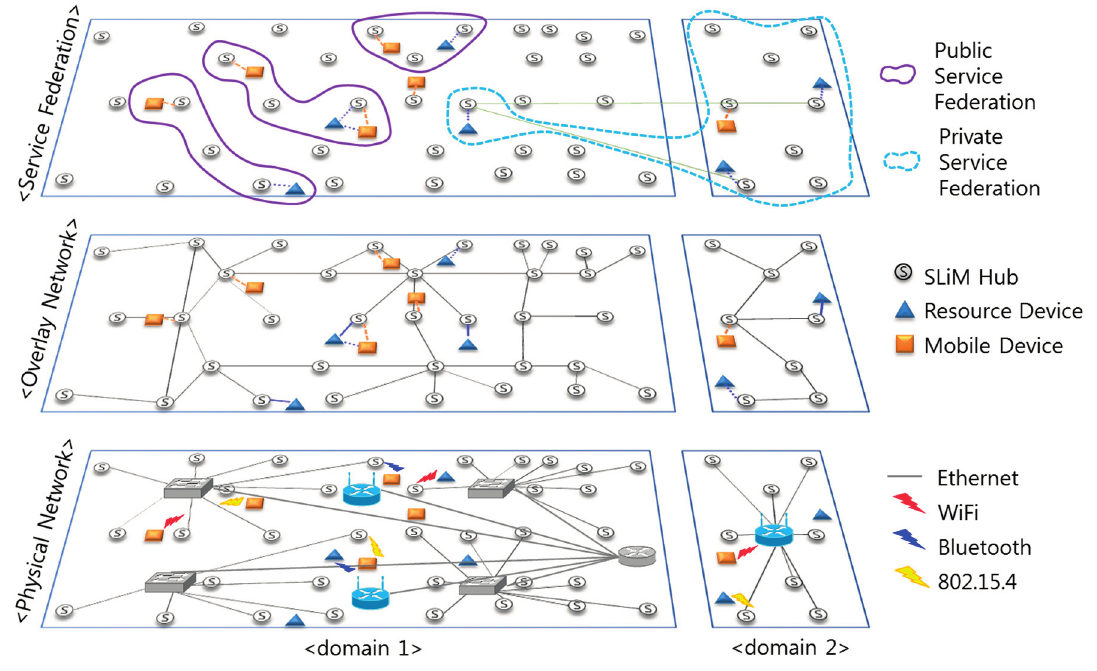
Figure 3. Service federations and an overlay network built on top of a physical